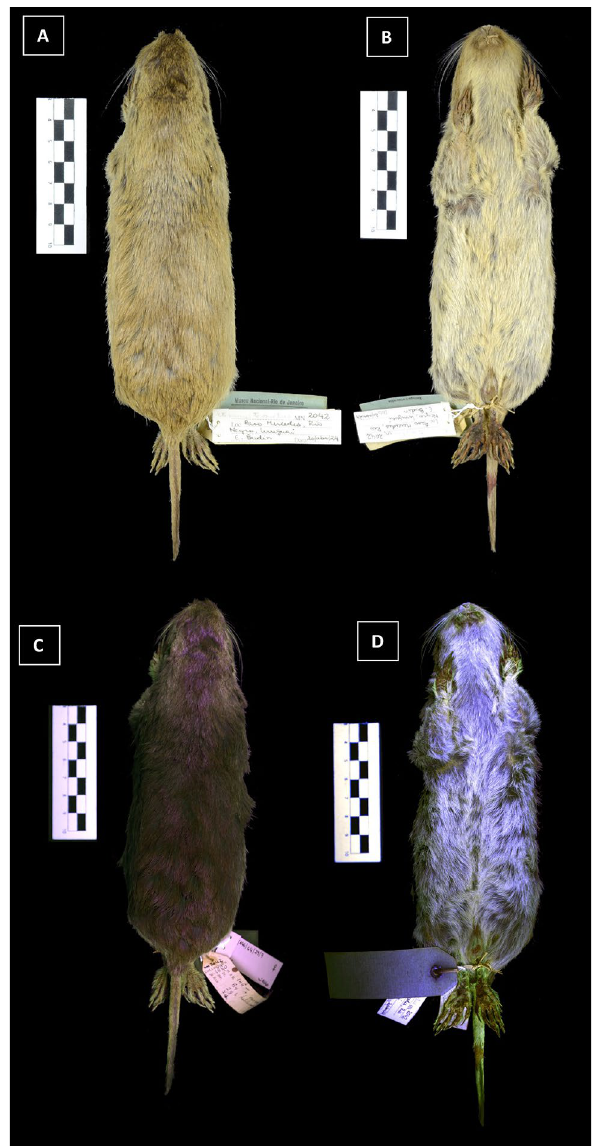
Figure 1. Photographs of Ctenomys torquatus (MN2042) under visible light (top row) and 395 nm ultraviolet (UV) light (bottom row). Dorsal ( A , C ) and ventral ( B , D )